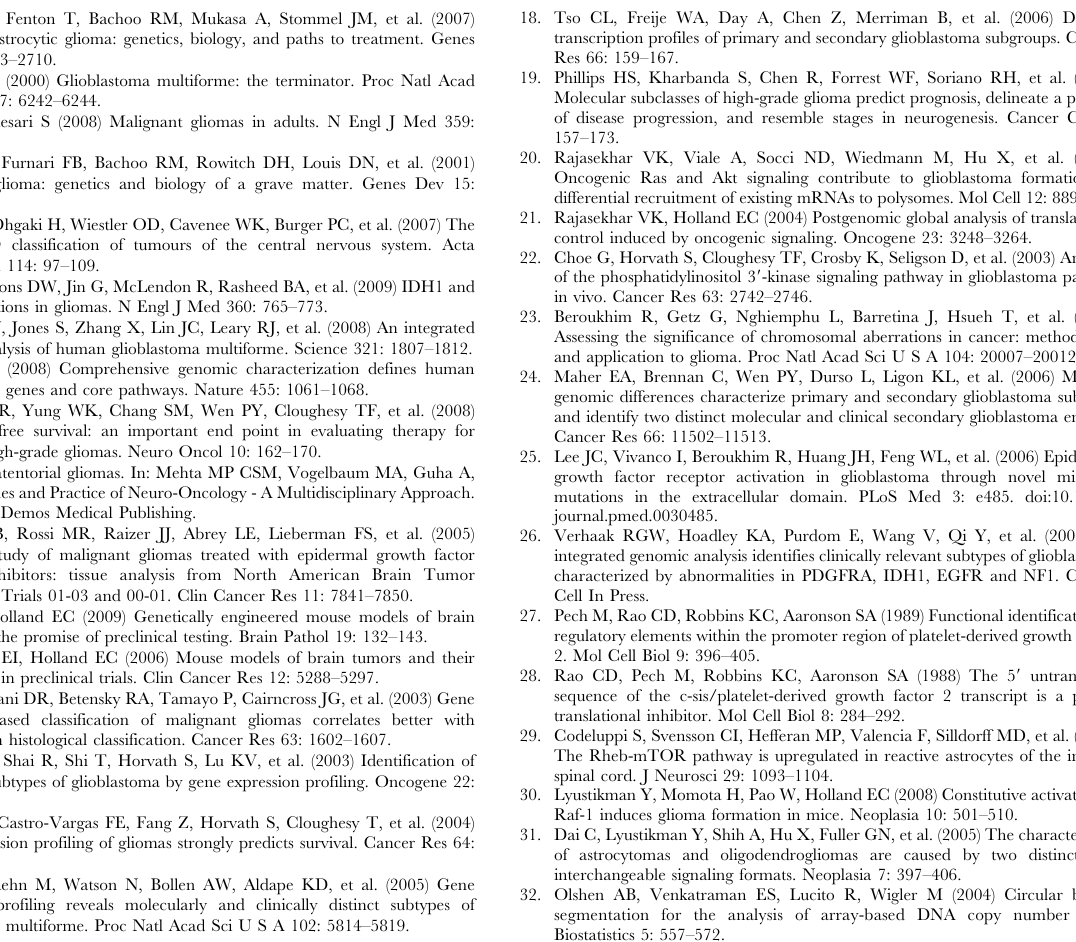
is pending. Focal amplifications in red and single-copy loss or homozygous deletion (light and dark green, respectively) are inferred from array-CGH log2 ratios (see Methods).